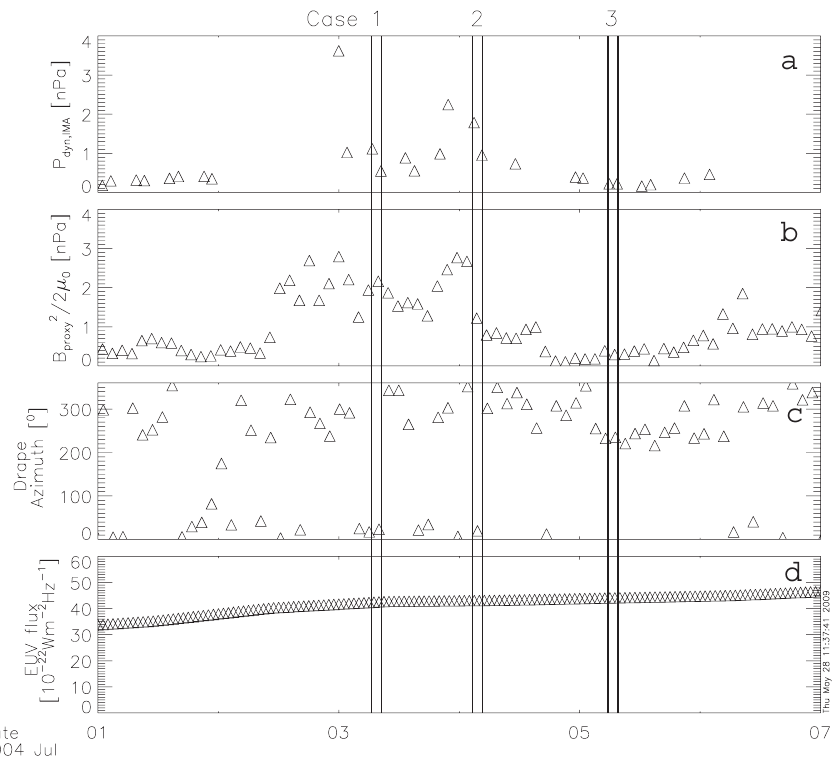
Fig. 2. Time series of (a) MEX measurements of solar wind dynamic pressure, (b) the MGS pressure proxy, (c) the MGS magnetic field draping direction and (d) solar EUV flux proxy. Three case studies of the variability of the MPB and BS are performed in Figs. 3–5 during the intervals indicated by the black vertical